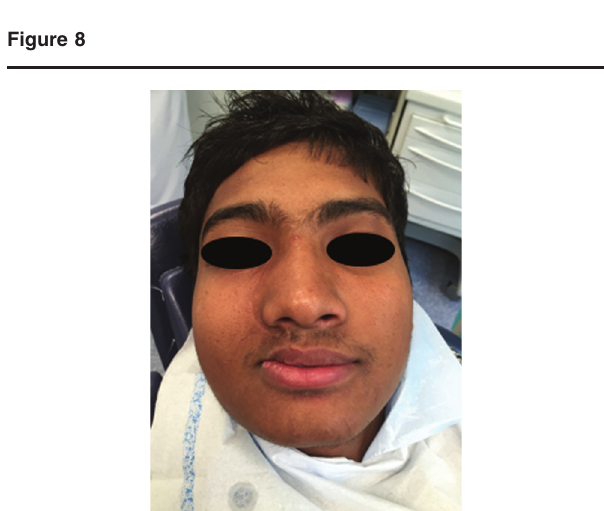
Facial form and prosthesis in function.